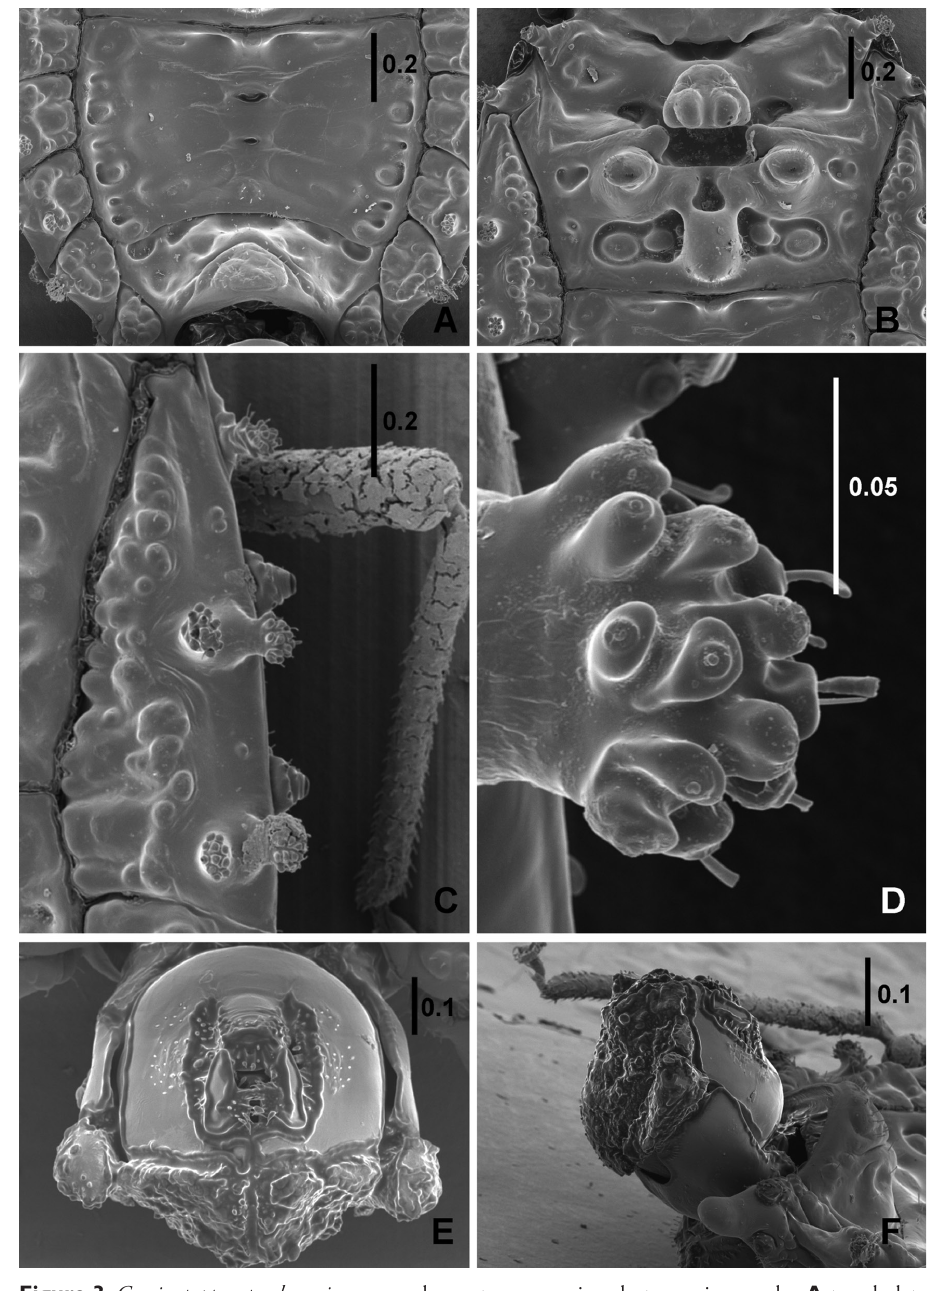
Figure 3. Cervinotaptera tomhenryi sp. n., male paratype, scanning electron micrographs. A tergal plate B mesonotum and metanotum with fused mediotergites I+II C triangular sclerite of fused dorsal external laterotergites II+III D apex of tubercle of dorsal external laterotergites II+III E pygophore dorsal view F pygophore lateral view. Scale bars in